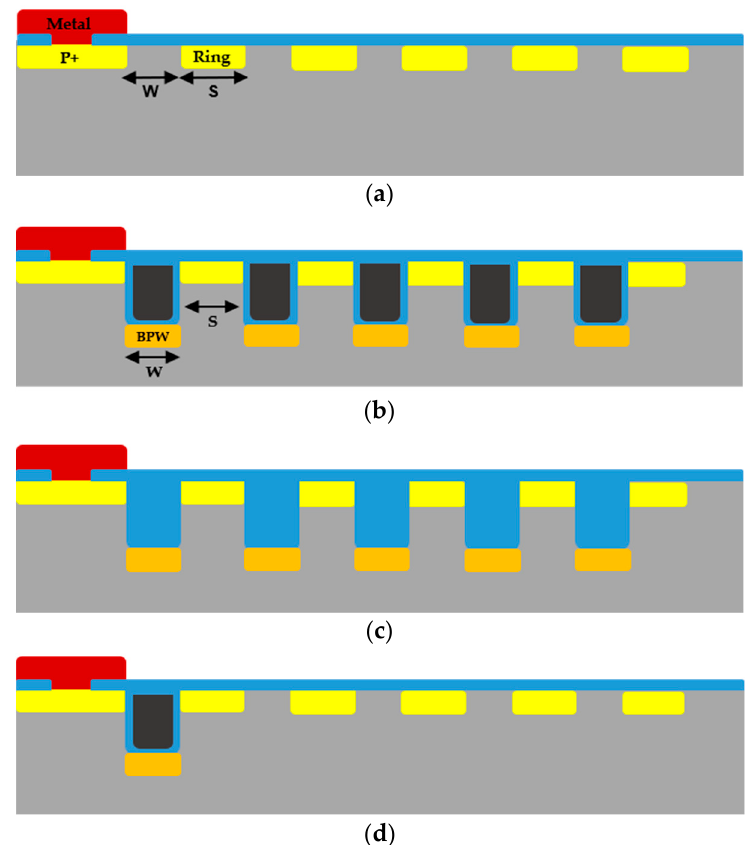
Figure 1. ( a ) Conventional floating field ring (FFR) edge-termination with a five-ring structure, ( b ) and ( c ) The poly-trench and oxide trench structure filled with polysilicon and oxide, respectively, and ( d ) The edge termination that mixes the FFR and trenched structure.